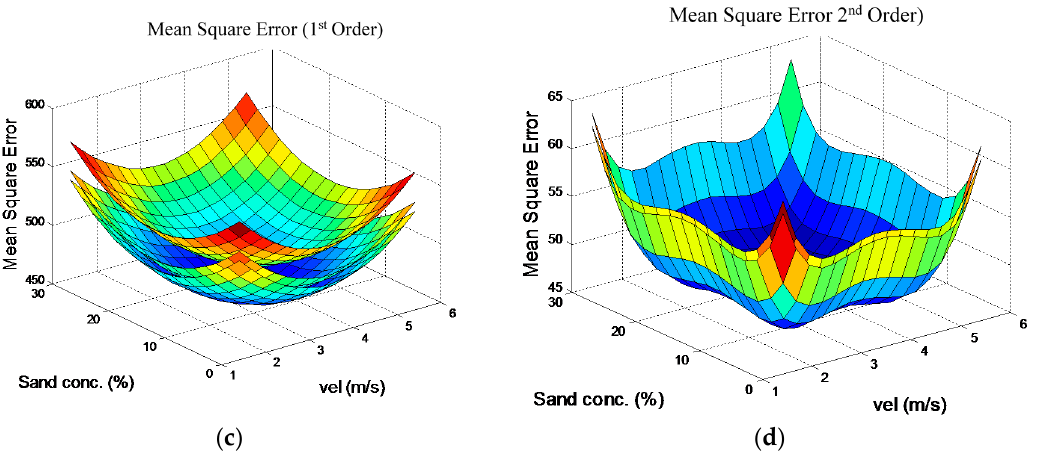
Figure 10. Mass loss versus velocity and sand concentration for constant times ( t = 20 h, 35 h, and 50 h); ( a ) First-order model; ( b ) Second-order model; ( c ) MSE for the first-order model; ( d ) MSE for the second-order model.